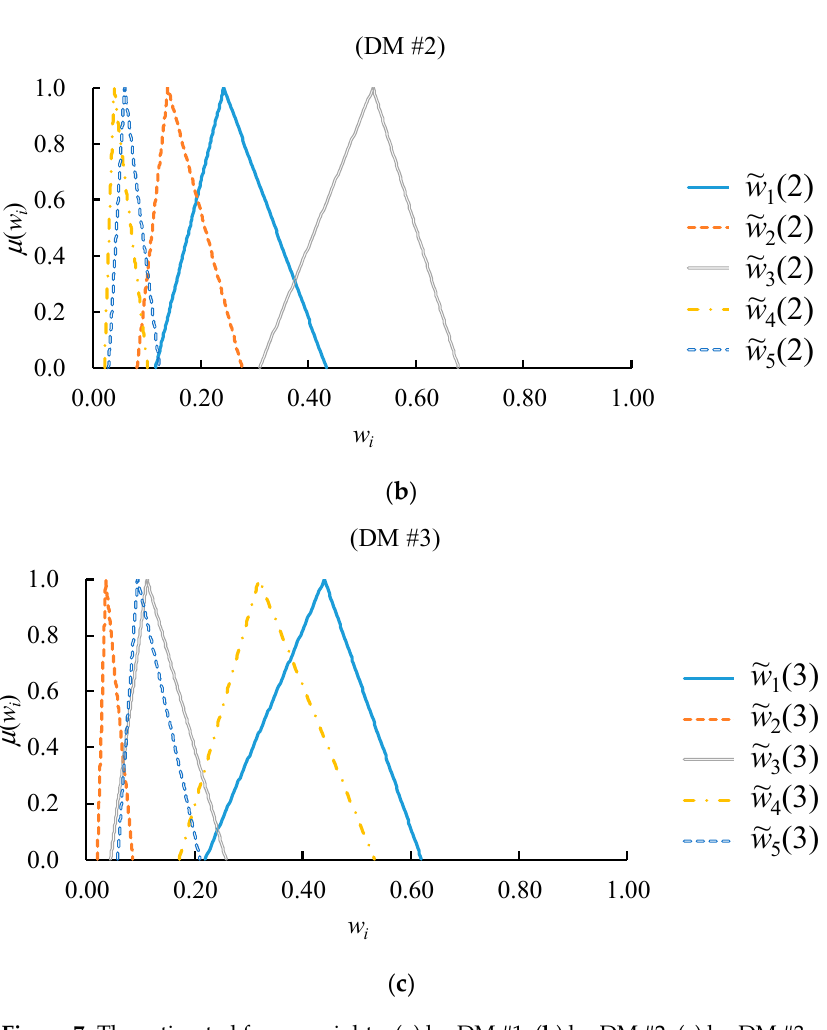
Figure 7. The estimated fuzzy weights: ( a ) by DM #1; ( b ) by DM #2; ( c ) by DM #3.